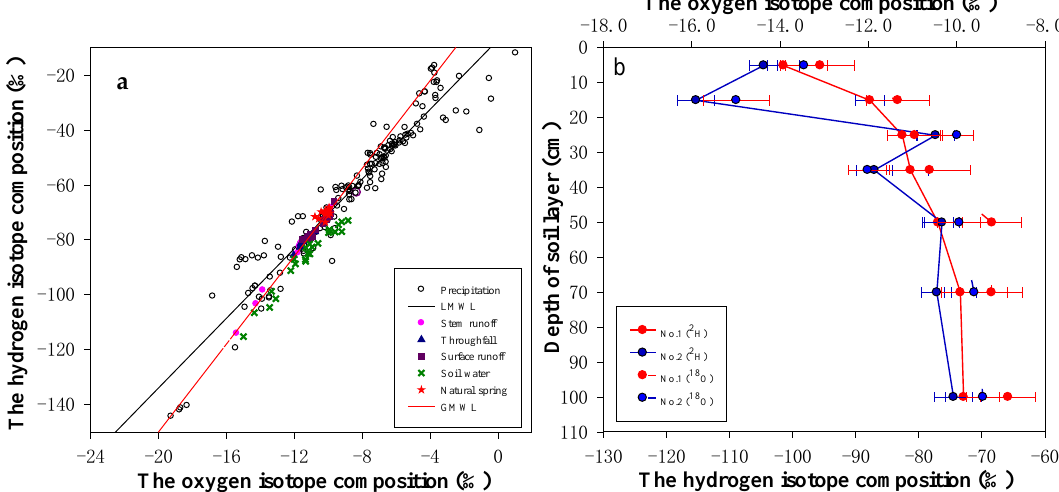
Figure 7. ( a ) Relationship between δ 2 H and δ 18 O of precipitation, stem runoff, throughfall, surface runoff, soil water and the natural spring. The black line shows the rainstorm precipitation process line where δ 2 H = 6.1 δ 18 O − 7.0 ( R 2 = 0.98, N = 36); ( b ) The variations of δ 2 H and δ 18 O values of soil water in the study area.